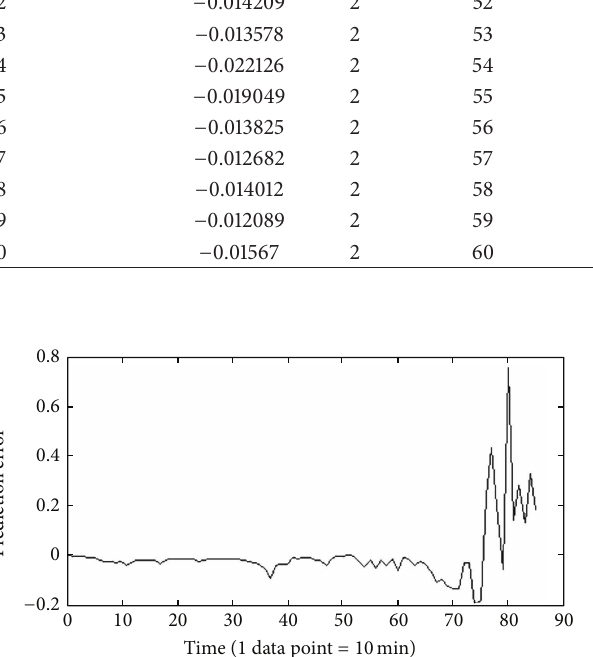
Figure 12: The prediction error of the SVM model.